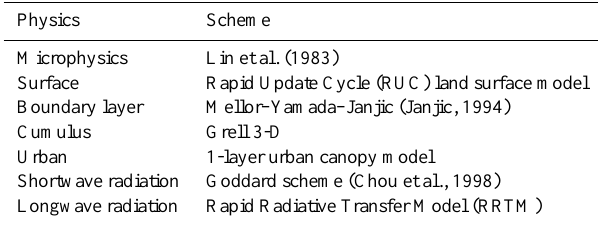
Table 1. Summary of physical